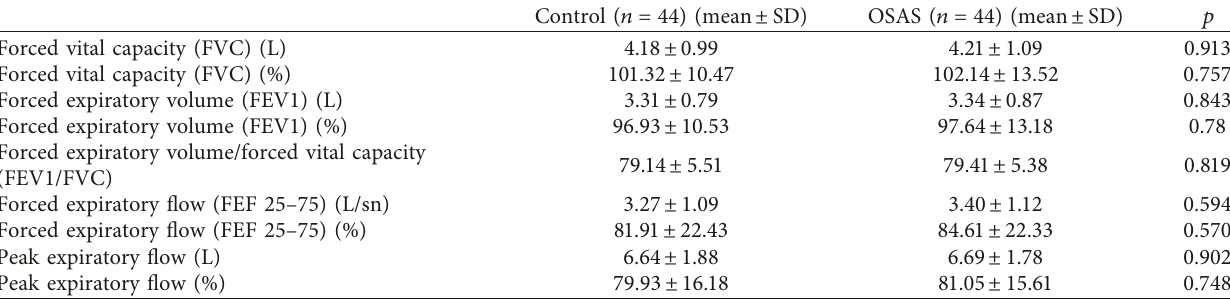
Table 3: Respiratory function test